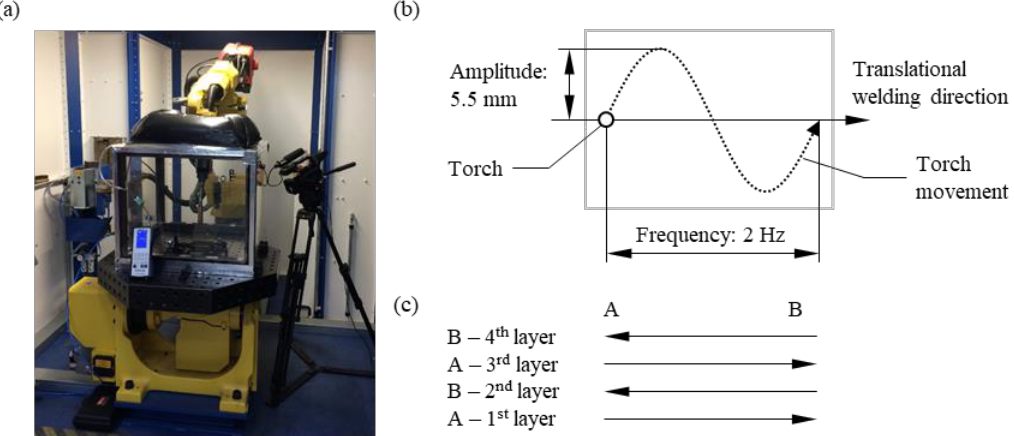
Figure 3. For the WAAM process ( a ) used WAAM machine, ( b ) applied sinus wave movement and ( c ) swapping of the starting point each layer. Table 1. Chemical composition of Ti-6Al-4V as-built by WAAM (max. weight %).